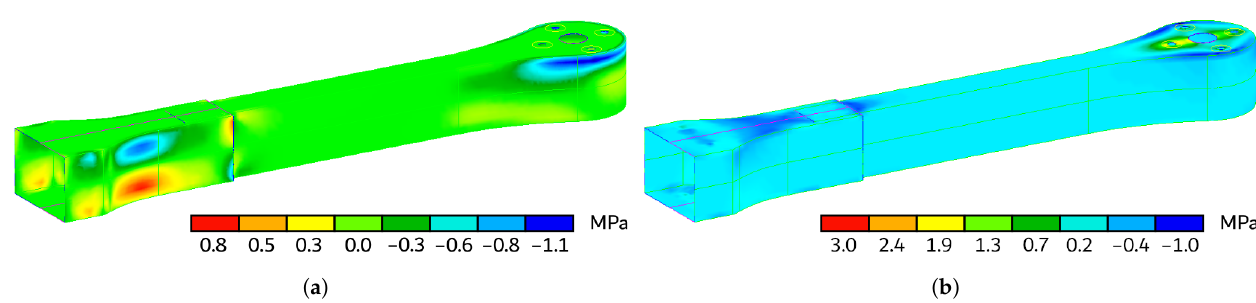
Figure 17. Transverse components of the stress tensor map, superimposed on the arm deformed shape. The results are expressed in MPa. ( a ) X component. ( b ) Z